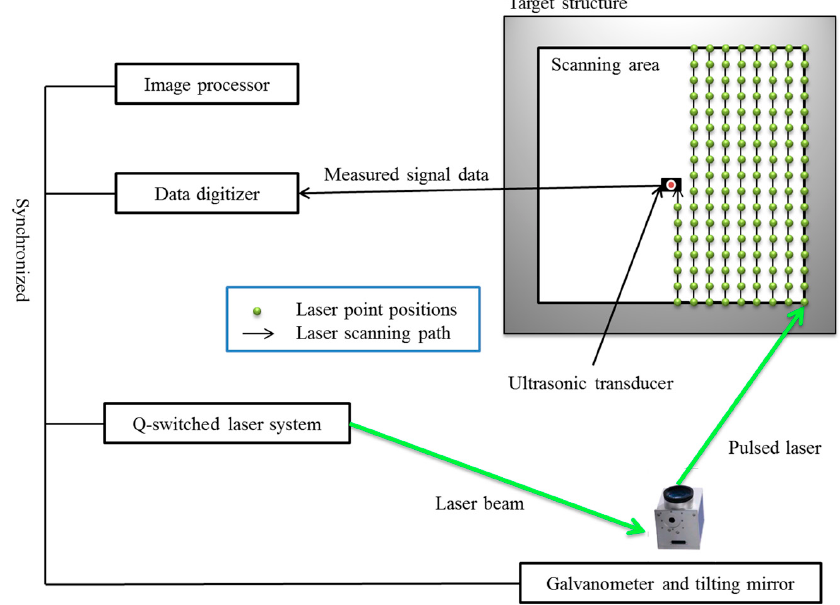
Figure 1. Laser-induced ultrasonic wave propagation imaging (UWPI) system.